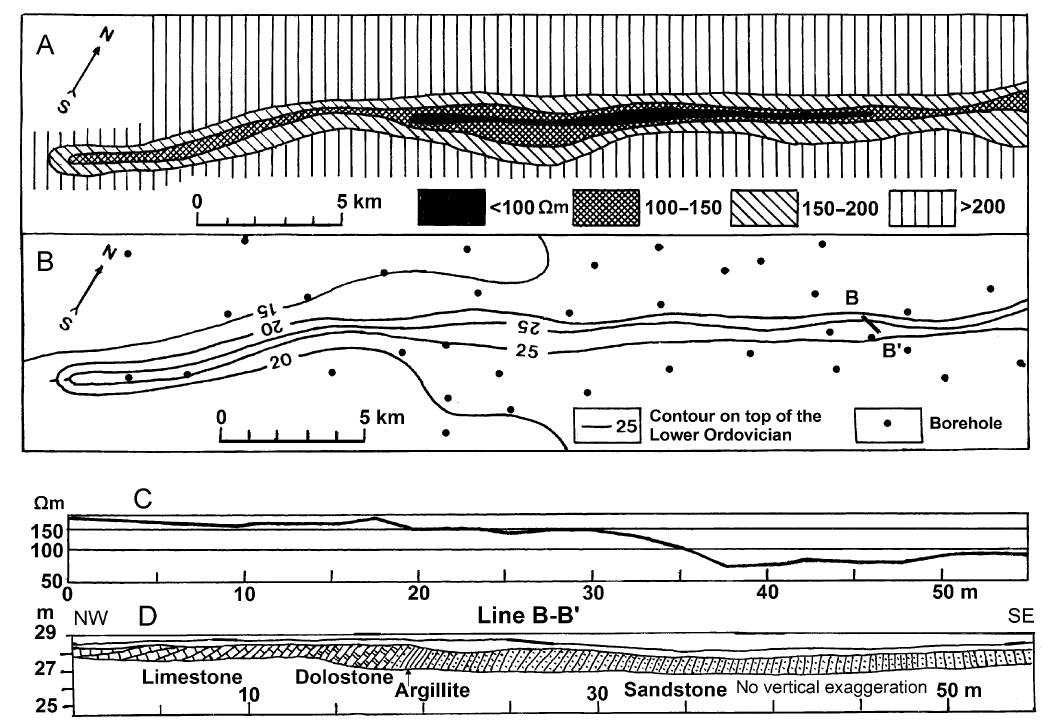
Fig. 4. A diapir, northeastern Estonia: resistivity ( A ) and structure ( B ) maps, resistivity curve ( C ) and cross section ( D